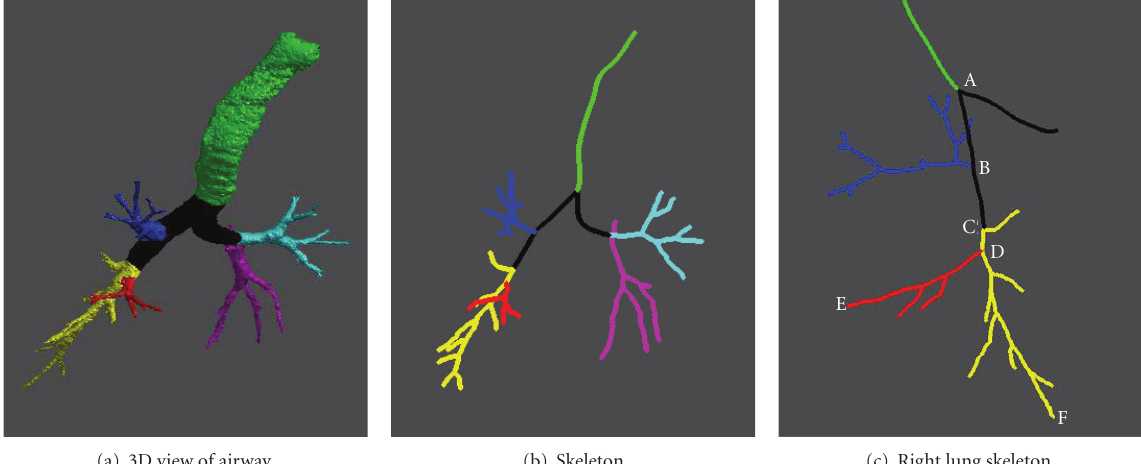
Figure 4: An example of classification of RML and RLL.